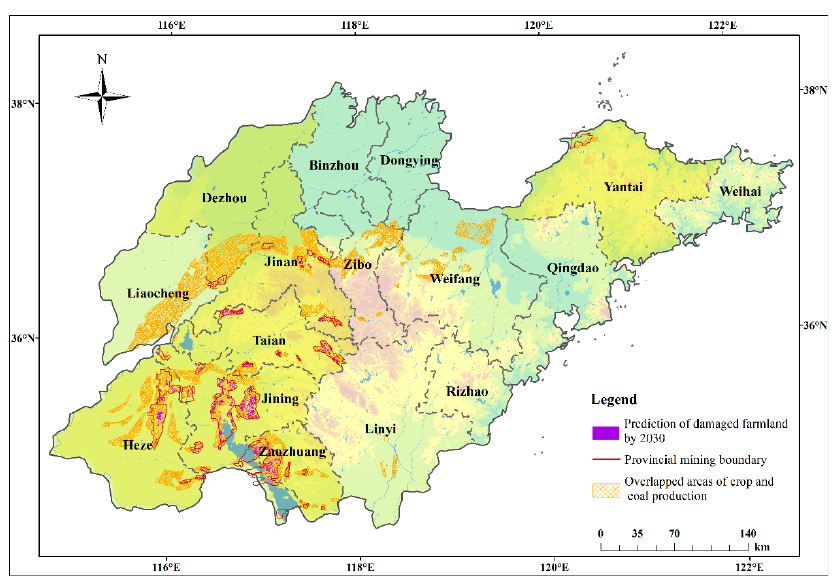
Figure 7. Prediction of damaged farmland area by 2030. Table 4. Damaged farmland by 2025 and 2030 in COA. There are also differences in the spatial distribution of cropland damage in different periods (Tables 5 and 6). Except for Jinan City, which stopped coal mining in 2021, other cities will continue to expand coal mining from 2021 until at least 2030. Before 2025, the damaged farmland area in Jining City was the largest, with an area of 3.17 × 10 4 ha. It is followed by Tai’an City, with an area of 1.51 × 10 4 ha, and the smallest is Dezhou City, which has an area of 0.08 × 10 4 ha. During 2025–2030, the damaged farmland area in Jining City is expected to increase the most, followed by Heze City, with Yantai City increasing the least. Compared with the period from 2021 to 2025, except for Jining City, Heze City, and Dezhou City, the area of each damage degree has changed significantly, and other cities Table 5. Prediction of damaged farmland area by 2025 in COA. have not changed